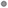
Stability of %ES over three testing sessions.A. Grey lines: individual participant data (broken lines: ESMs; solid lines: Norms). Black lines and points: group data, shown as the mean±95% CI (ESM ■; Norm ●). Black dashed line shows the 30% criterion level. B. 3D correlation plot of %ES over three sessions for ESMs (●) and Norms (●).